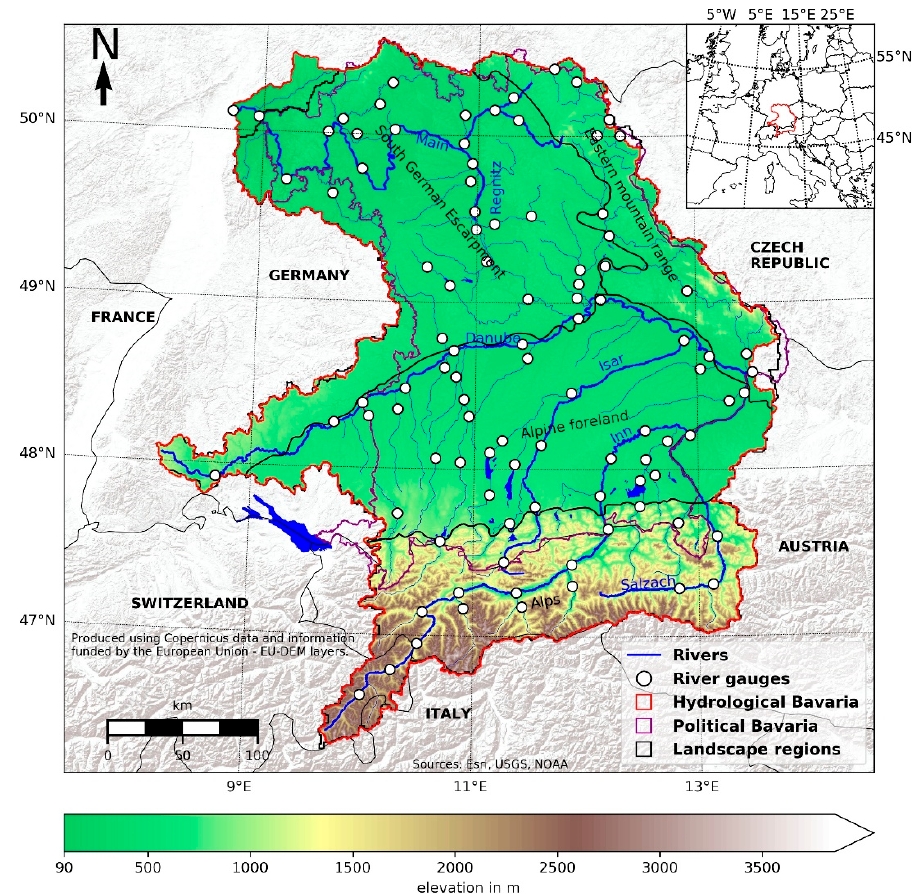
Figure 1. Map of the Hydrological Bavaria (red line) comprising different landscape regions (black lines) and the political Bavaria (purple line). The map further indicates the 98 gauges used in this study (white dots) at their respective rivers (blue lines).